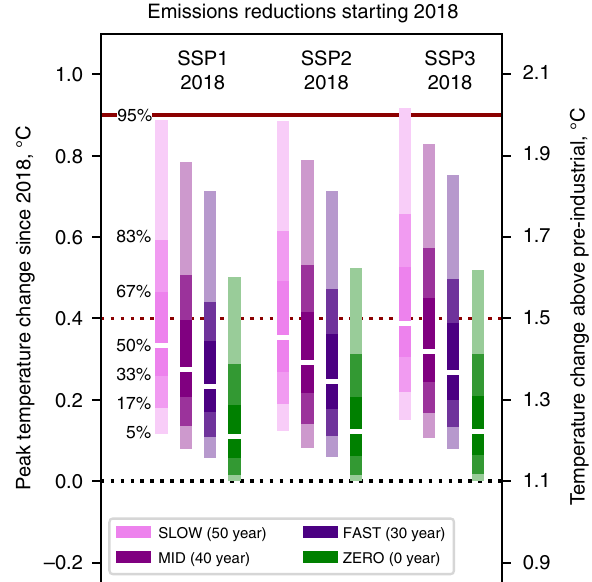
Fig. 2 Peak temperature change compared with 2018 for different rates of fossil fuel phase-out (FAST, MID and SLOW) plus an abrupt cessation of all emissions (ZERO) from 2018. MID scenarios assume a phase-out of fossil fuel infrastructure based on historical generator lifetimes 13 . FAST and SLOW cases vary these lifetimes by subtracting and adding 10 years, respectively. Shown are results for emissions under SSP1, SSP2 and SSP3 until 2018. Supplementary Figure 7 shows the corresponding ranges for 2100 temperatures. SSP2-2018-MID and SSP2-2018-ZERO are consistent with the technological and zero emissions commitments in Fig.